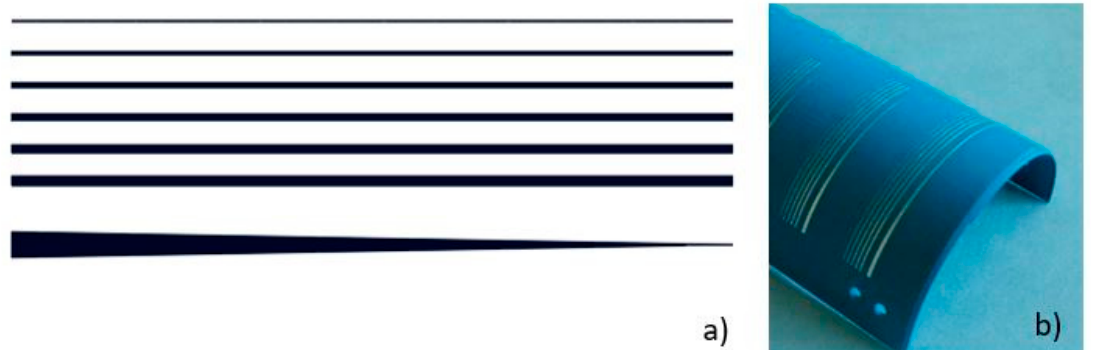
Figure 2. Test structures for surface metallization: ( a ) test layout, width variation for lines from 70 µm to 200 µm; ( b ) printed layout on the sintered multilayer.